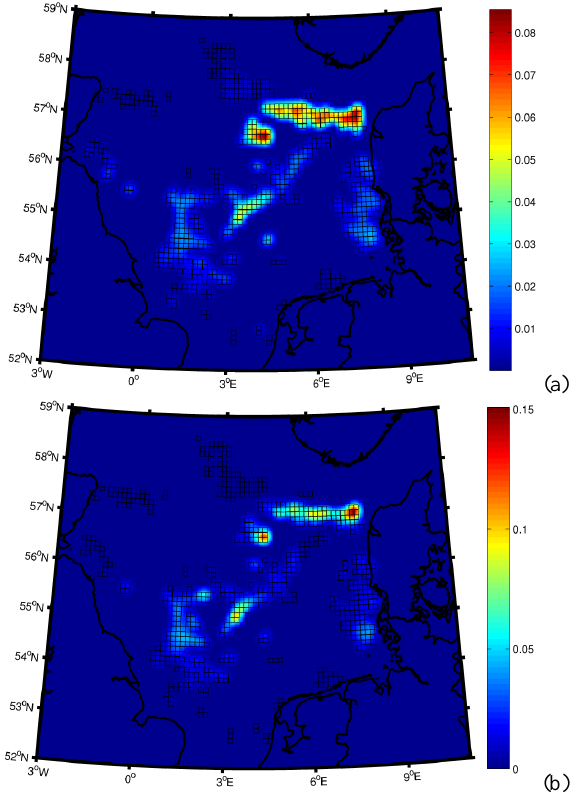
Fig. 11. Biomass distribution (in ktkm − 2 ) for 1996 (a) with post- settlement migration (Eq. A14) and (b) without post-settlement mi-